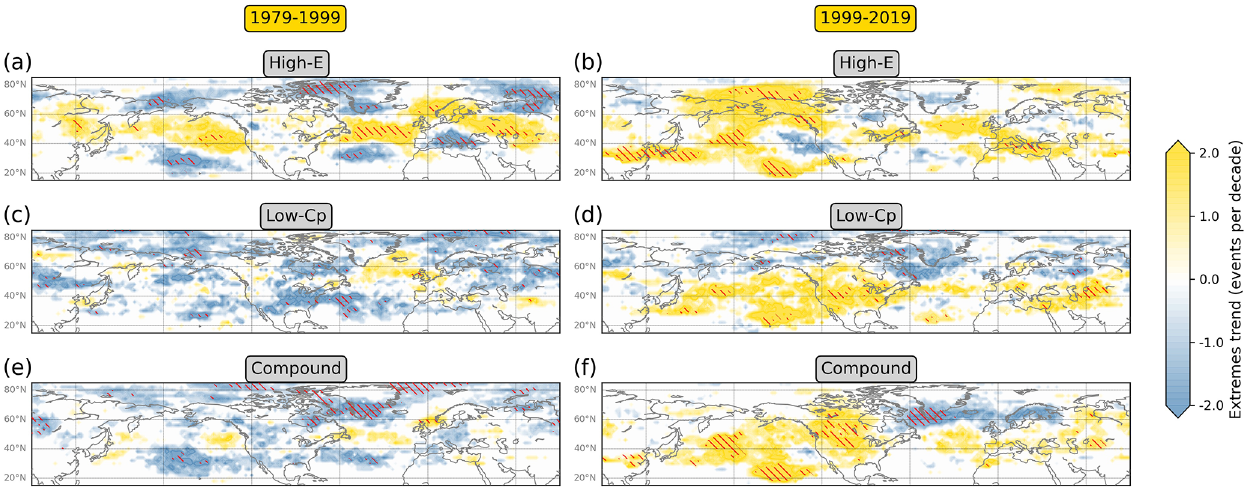
Figure 11. Maps of 1979–1999 linear trends (Theil–Sen estimator; colour shading) in the number of (a) high- E extremes, (c) low- c p extremes, and (e) compound high- E /low- c p extremes at 300hPa for DJF in ERA5. (b, d, f) Same as panels (a) , (c) , (e) , but for 1999–2019. Red hatching indicates areas where the trend monotonicity is statistically significant at the 0.10 significance